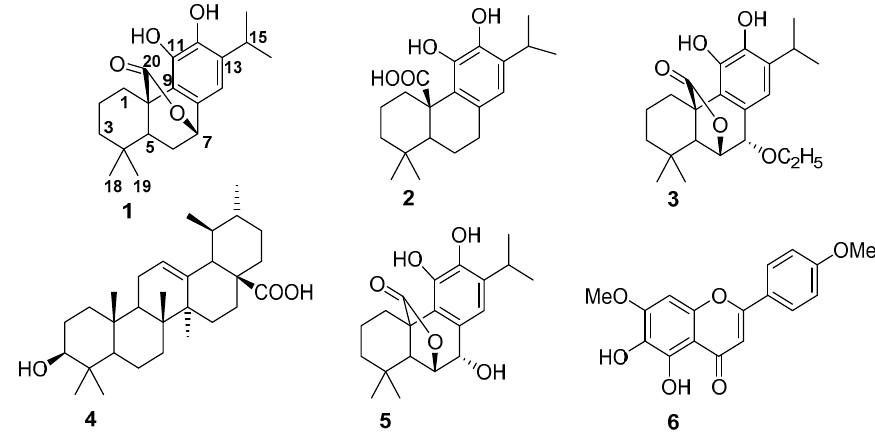
Figure 1. Chemical structures of the isolated compounds.